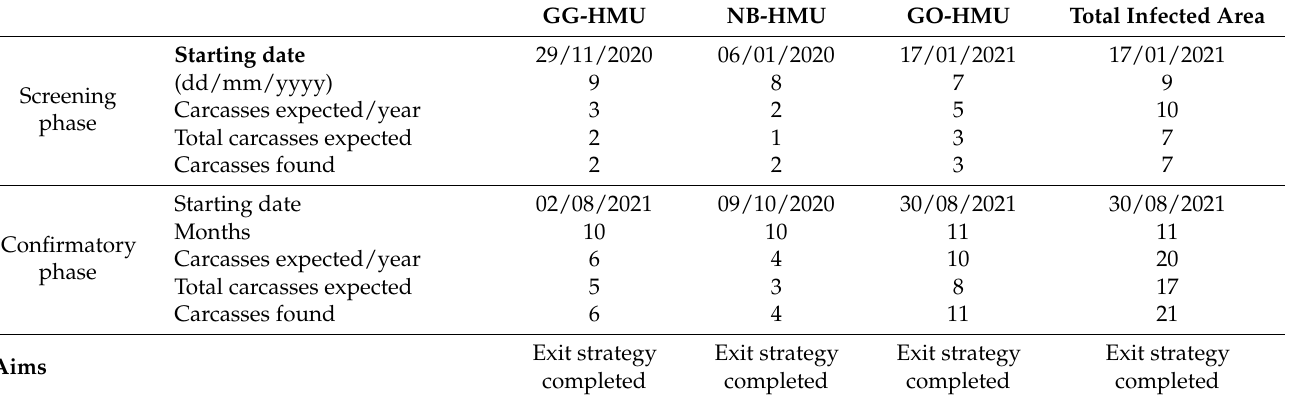
Table 6. Exit strategy indicators for the three HMUs that include the 2021 infected area, based on the 2% probability of a failure scenario and the estimated number of expected carcasses by the WBC-Counter tool using the wild boar density approach. Data are reported by the screening and confirmatory phases, including the starting date (last virus or seropositive young wild boar detection), duration (months), number of carcasses expected during one year, proportion of carcasses expected for the duration of the phase, and the number of carcasses